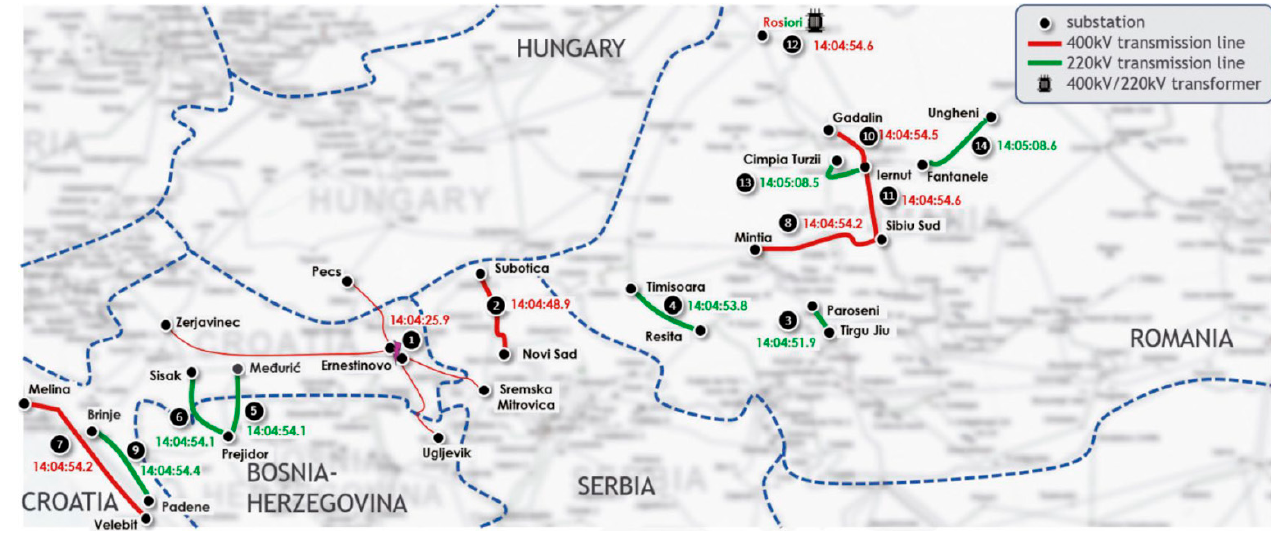
Figure 7. Location of the main transmission system elements that have tripped.